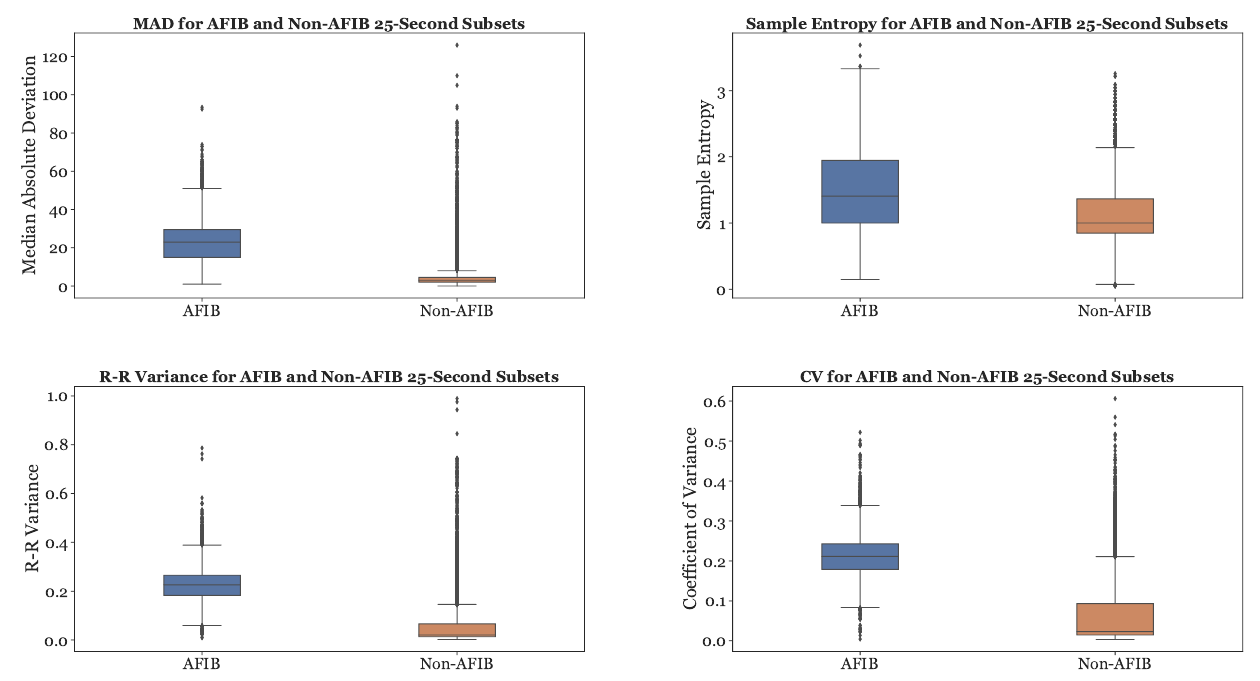
Figure 9. Sample features of MAD, Sample Entropy, R-R Variance, and Coefficient of Variance (CoefVar) Across AFib and Non-AFib